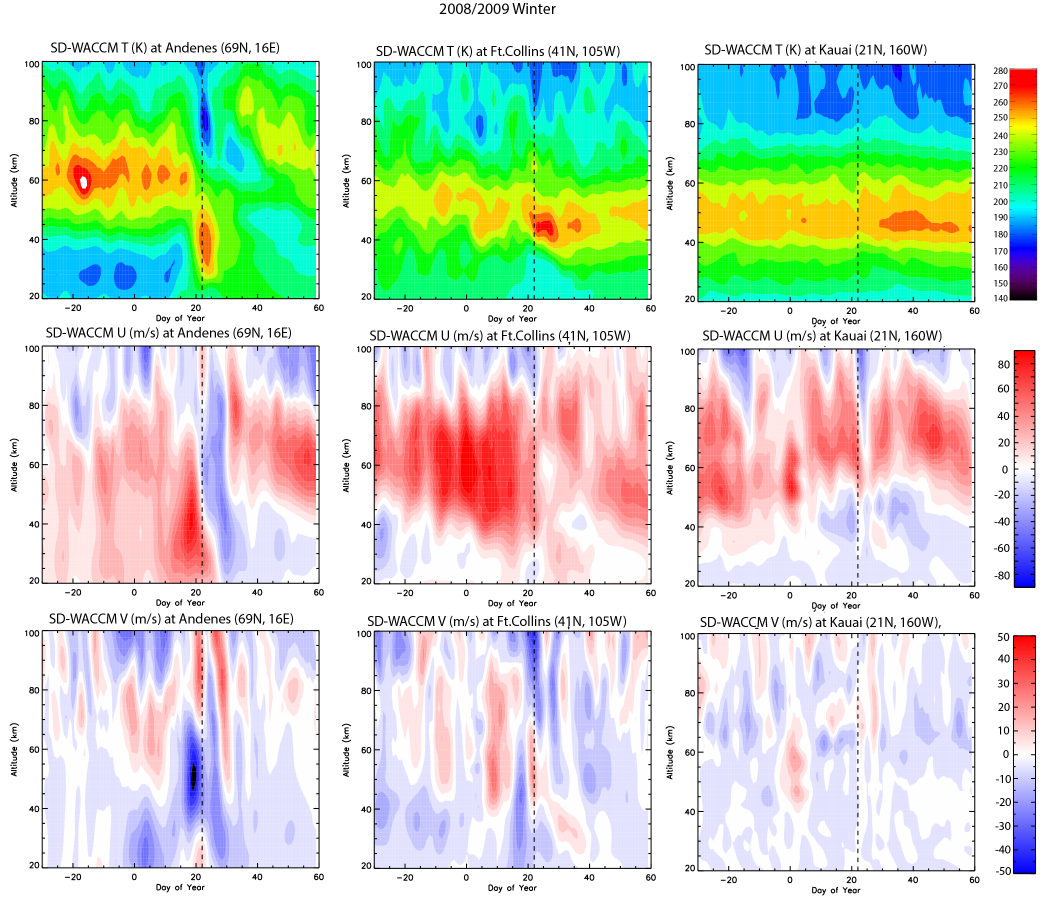
Figure 10. The temperature (top panel), zonal-mean zonal wind (middle panel) and mean meridional wind (bottom panel) from the WACCM at grid points closest to Andenes (69 ◦ N, 16 ◦ E), Fort Collins (41 ◦ N, 105 ◦ W) and Kauai (21 ◦ N, 160 ◦ W) from left to right during the 2008–2009 northern hemispheric winter. The dotted line indicates the day of peak warming (22 January) over the polar